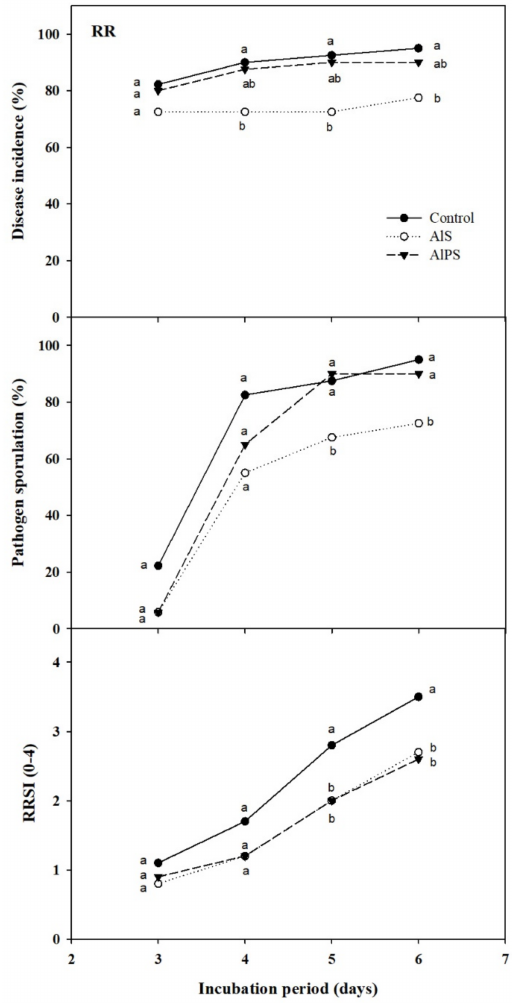
Figure 4. Curative activity of 1 min dips at 20 ◦ C in water (control) or aqueous solutions of aluminum sulfate (AlS) and aluminum potassium sulfate (AlPS) at 50 mM against Rhizopus rot (RR) on ‘Ambra’ nectarines artificially inoculated with Rhizopus stolonifer , dipped 2–3 h later, and incubated for up to 6 days at 20 ◦ C. Disease incidence, Rhizopus rot severity index (RRSI, score 0–4), and pathogen sporulation are presented. For each dependent variable and evaluation date, means with different letters are significantly different according to Fisher’s protected LSD test ( p < 0.05) applied after an ANOVA. Represented values are means from two repeated experiments. Incidence and sporulation values were arcsine-transformed. Non-transformed means are